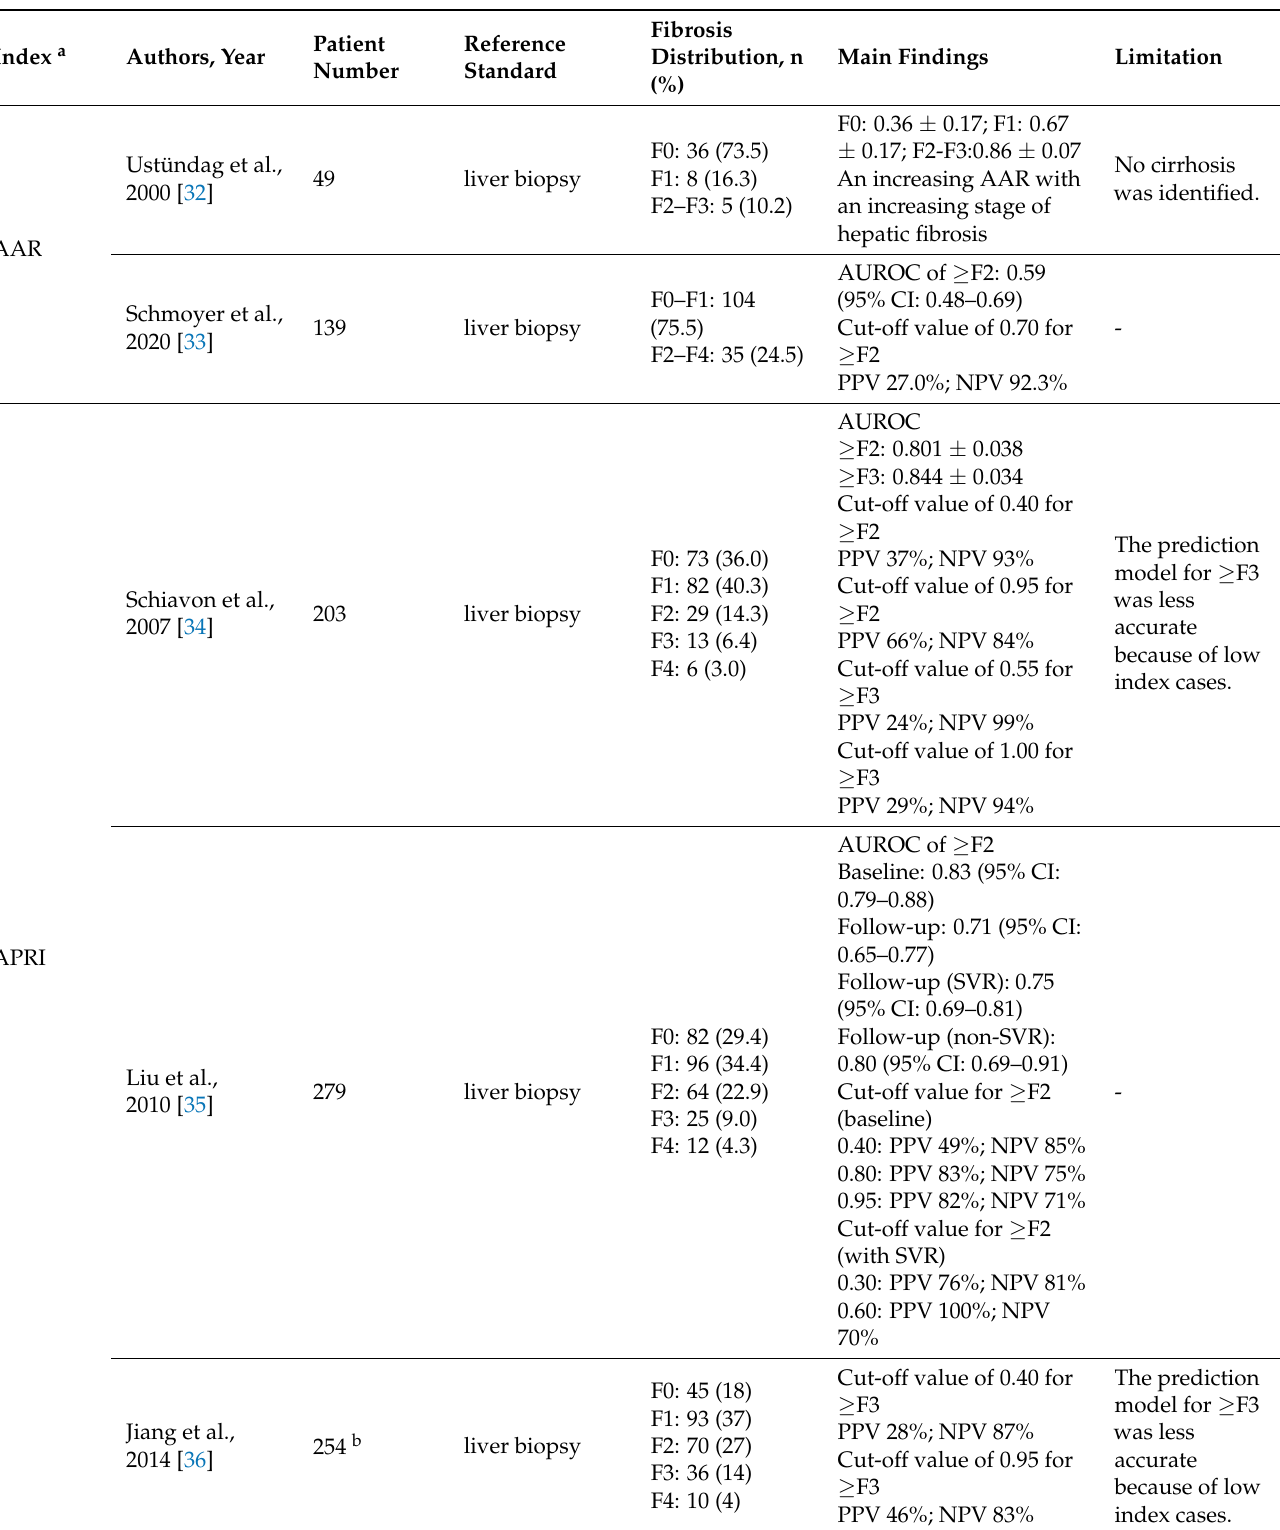
Table 1. Summary of biochemical indices to predict hepatic fibrosis in hemodialysis patients with HCV